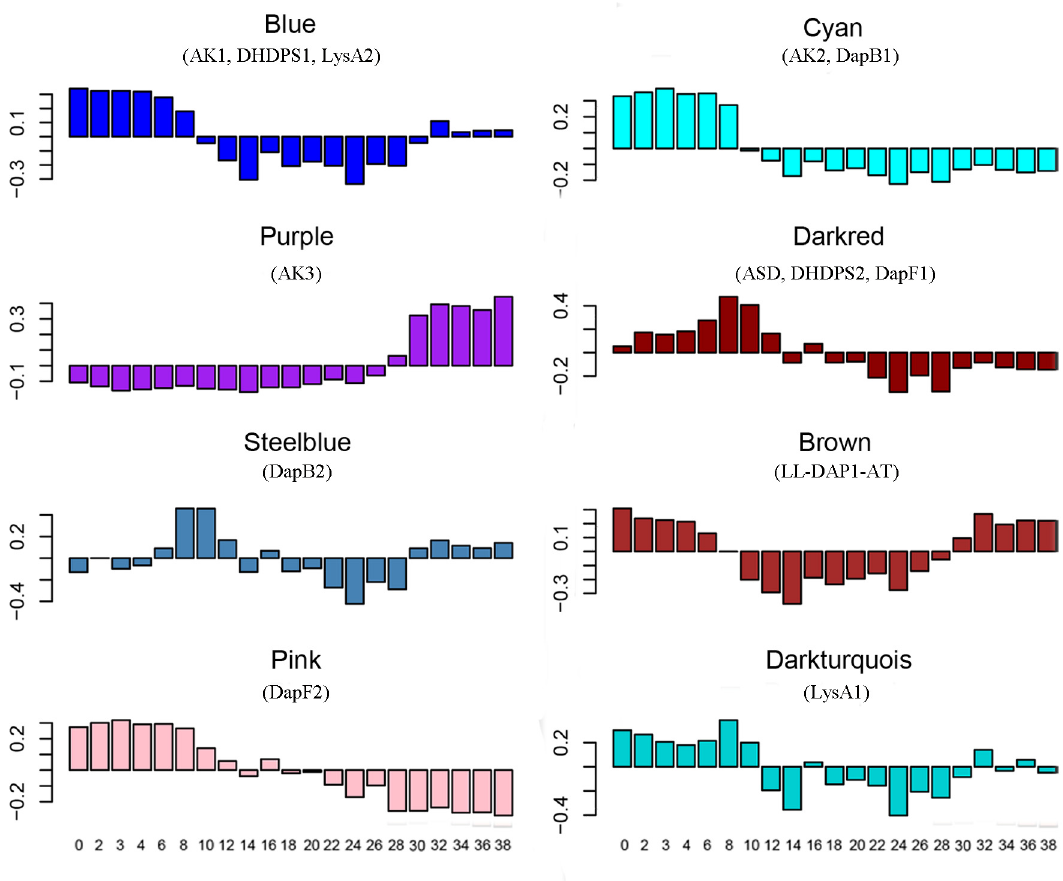
Fig 2. Expression pattern of LBPGs coexpressed genes. The module eigengenes are used to represent the genes expression pattern within each module. Each bar represents one sample (days after pollination) and the color represents the module color, the LBPGs was list below the module name. The value of the module eigengenes for each sample is displayed on the y axis.